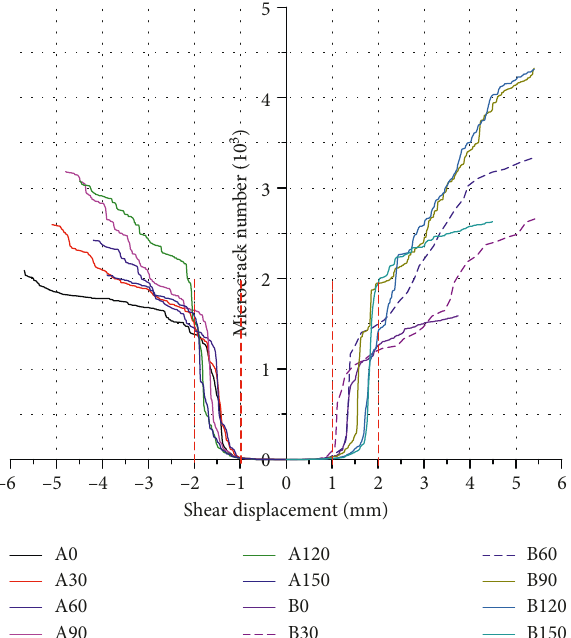
Figure 23: Microcrack number versus shear displacement.